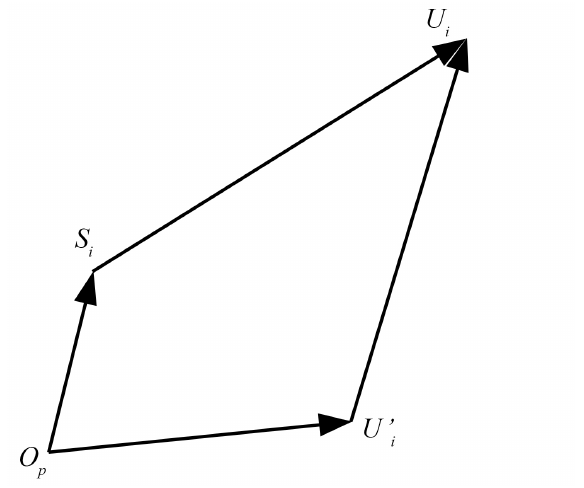
Figure 7. Closed-loop vector